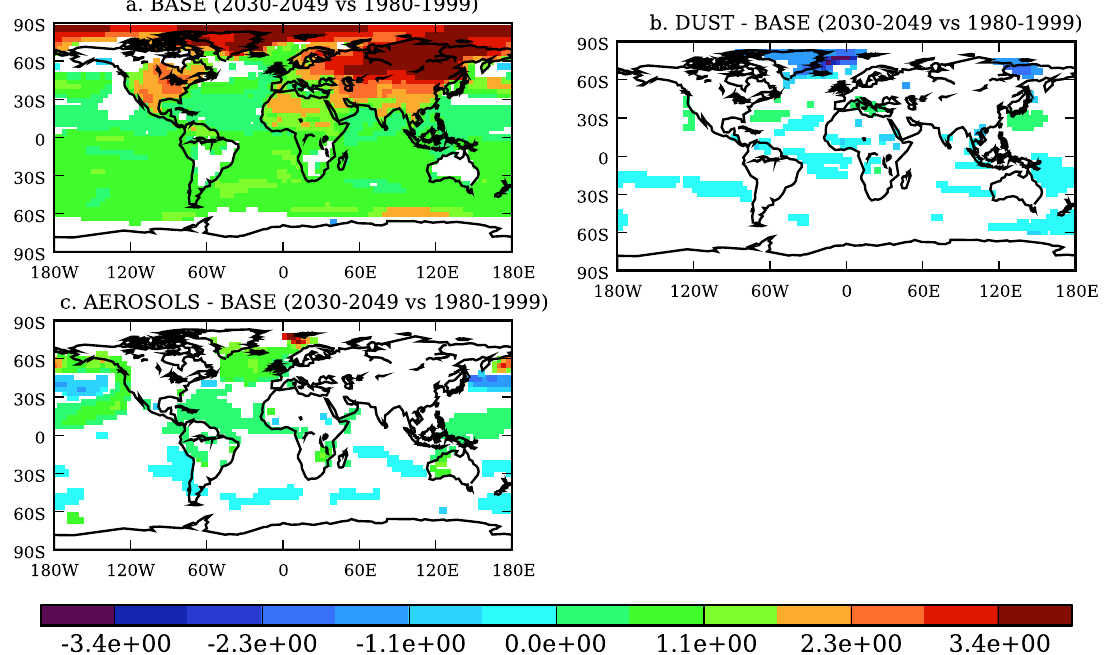
Fig. A3. Surface temperature (K) differences for 2030–2049 relative to 1980–1999 control for each case: (a) mean change for 3 ensemble BASE case members, (b) differences from BASE case differences for interactive dust (DUST), (c) differences from BASE case for interactive aerosols (AEROSOL). Only changes significant at the 95% level are shown in color. Note that panels (b) , and (c) show differences from the 3 BASE case differences from preindustrial (for example: (DUST2030-2049 minus DUST-control) minus (BASE2030-2049 minus BASE-control)).